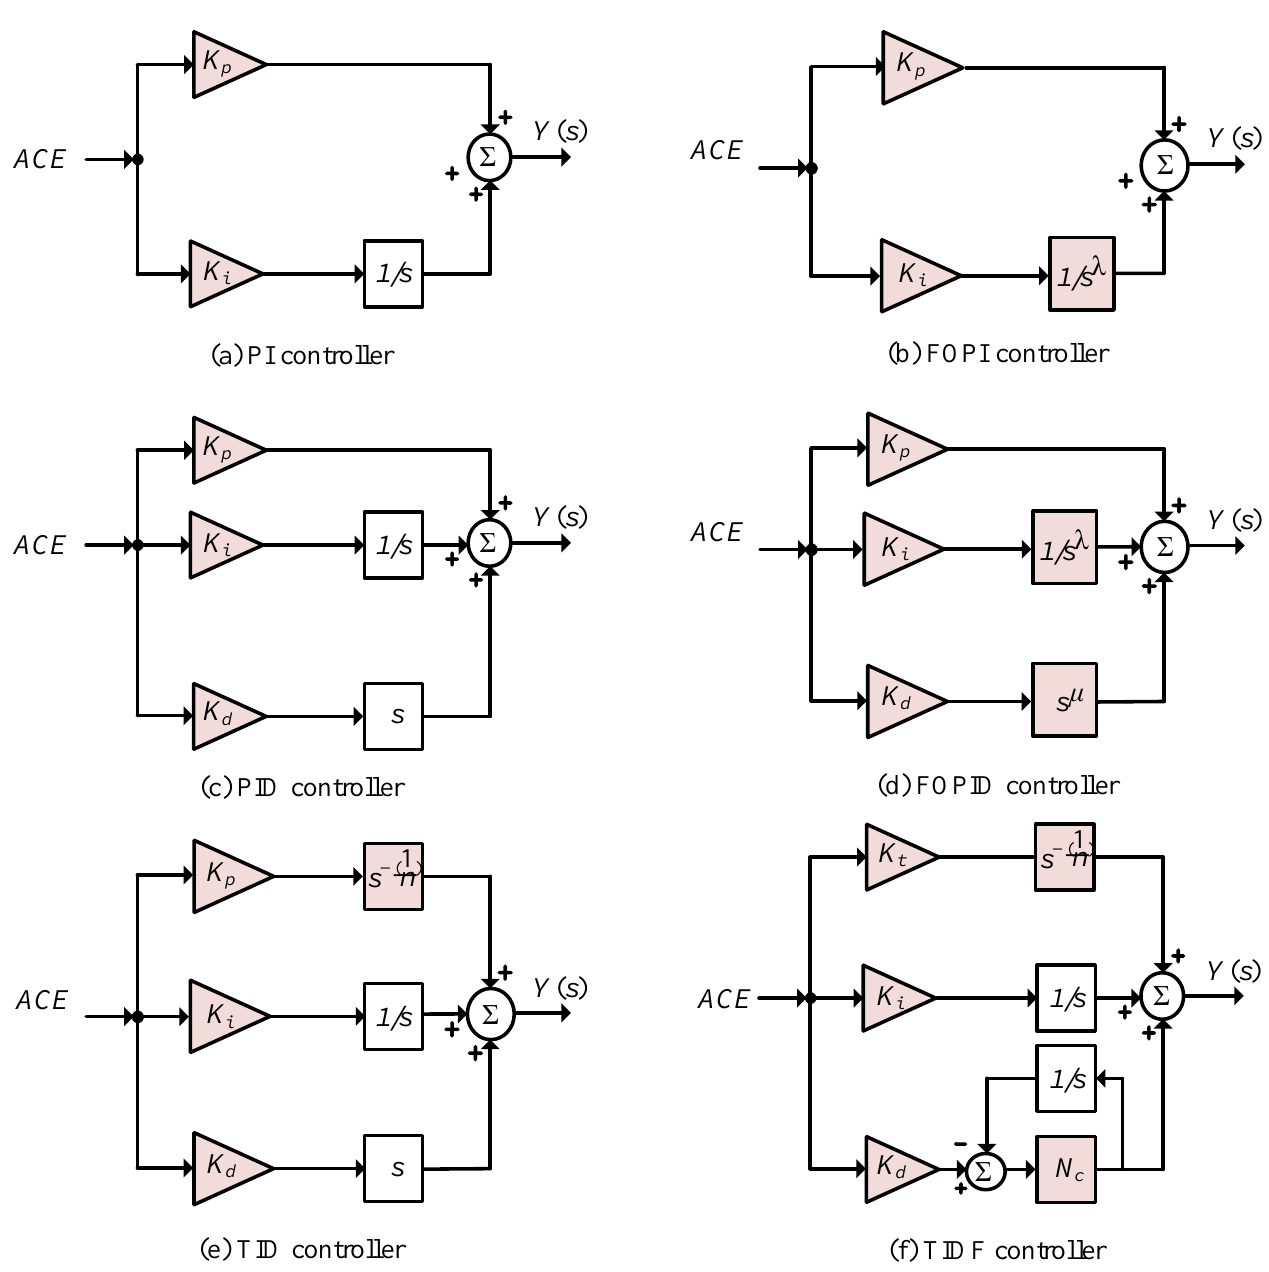
Figure 3. Conventional used IO-based and FO-based controllers for LFCs